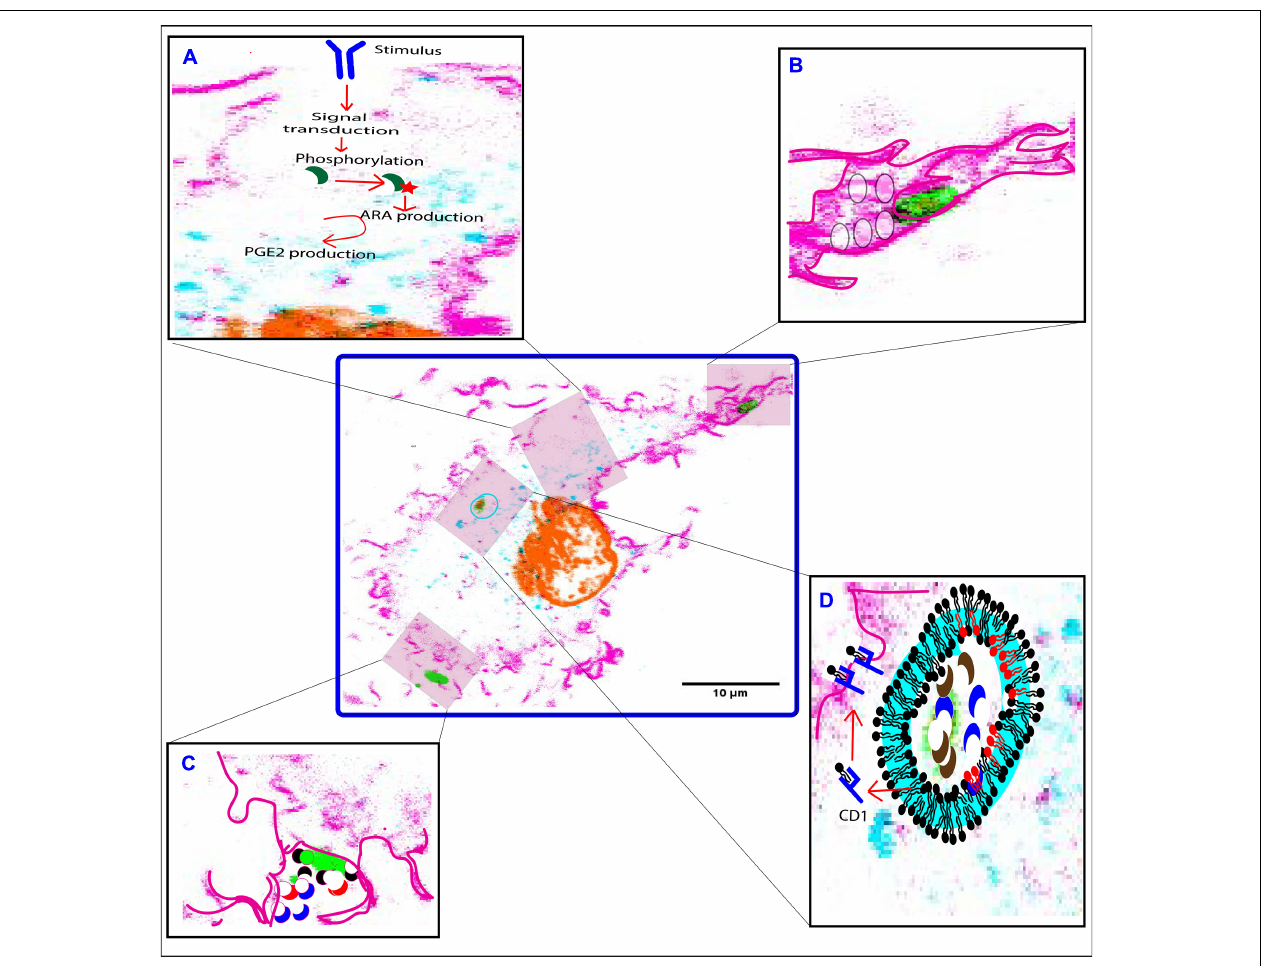
FIGURE 3 | Functions of PLA 2 forms at different stages of phagocytosis. (A) cPLA 2 α (green crescent) is phosphorylated in response to an extracellular pathogenic stimulus. This leads to translocation of cPLA 2 α to the perinuclear area, where it hydrolyzes membrane phospholipids to generate arachidonic acid (ARA) which in-turn gets metabolized to eicosanoids by the action of the COX-2 enzyme. (B) iPLA 2 (not shown) translocates to the phagocytic cup, and facilitates fusion of secretory vesicles (translucent circles) to provide additional membrane required for the extension of the pseudopodia. (C) sPLA 2 -II/V (red and black crescent) and LPLA 2 (blue crescent) are released at the phagocytic cup to degrade invading microbes (green). (D) LPLA 2 (blue crescent) and aiPLA 2 (brown crescent) work together to degrade and process microbes within the phagolysosome. The processed lipids are then loaded onto a CD1 molecule (blue structure) to be presented on the cell surface to activate T cells. Both LPLA 2 and aiPLA 2 repair peroxidized lipids of the phagosomal membrane that might occur due to increased NOX2 activity. The repaired phospholipids are shown in red. F-actin is pink, DNA is orange, LAMP1 is turquoise and LPS is green. Highlighted pink boundary in insets (B–D) shows pseudopodia, phagocytic cup, and plasma membrane, respectively. Highlighted turquoise boundary at the phagosome membrane is to show recruited